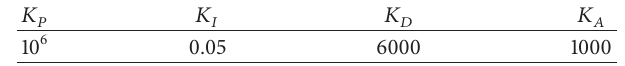
Table 7: Reference values of the P